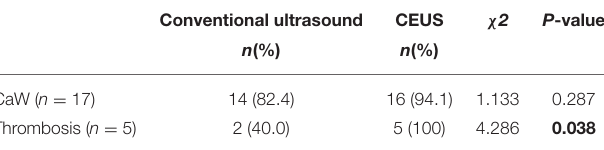
onset of stroke and small-vessel disease (24). Therefore, it is very important for patients with CaW to control their blood pressure.